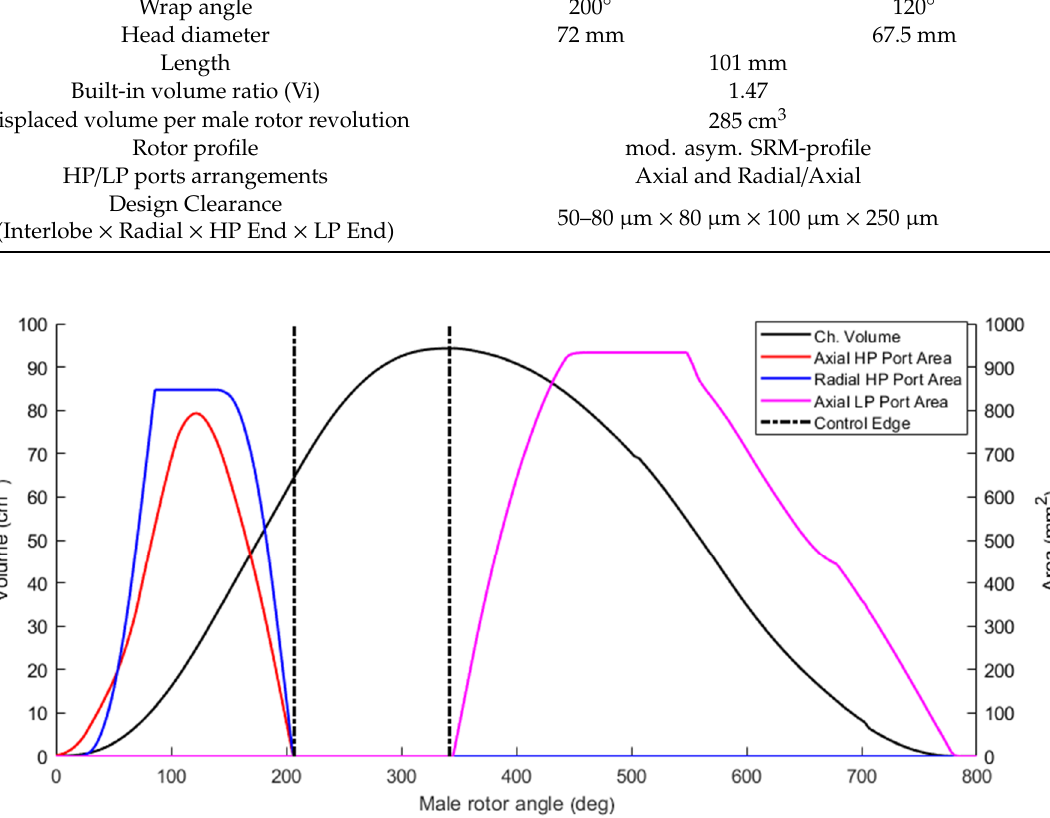
Figure 1. Port areas and volume curve of the screw expander GL51.2-M.